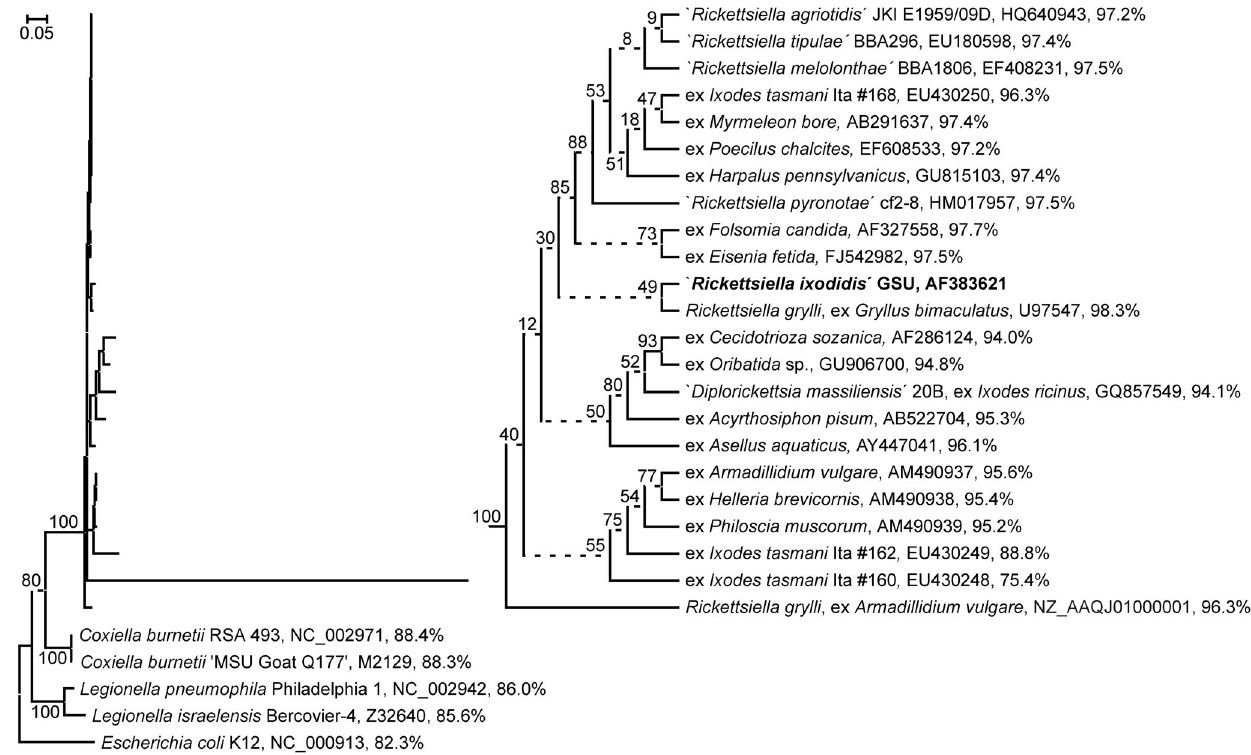
Figure 1. Bacterial ML phylogeny generated from 16 S ribosomal RNA encoding sequences. Terminal branches are labelled by genus and species, pathotype, strain and/or original host designations, GenBank accession numbers as well as pairwise nucleotide sequence identity percentages as calculated from a p-distance matrix with respect to the ‘ Rickettsiella ixodidis ’ GSU sequence. Numbers on internal branches indicate bootstrap support values; branches that do not receive . 90% bootstrap support are represented by dashed lines. The phylogram has been rooted using Escherichia coli as outgroup. The size bar corresponds to 5% sequence divergence. To enhance resolution, the upper clade of the phylogram that comprises Rickettsiella -like bacteria, has been extended into a cladogram. GenBank accession numbers AM490937-39 and EU430248-50 designate partial 16 S rRNA gene sequences comprising only 40–70% of the complete 16 S rRNA marker sequence. The tree has been reconstructed from ClustalX aligned sequences; an essentially identical ML tree has been generated from a T-Coffee based nucleotide sequence alignment (not shown).